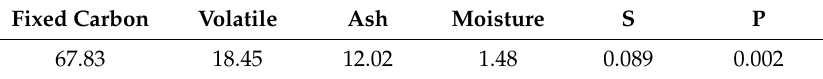
Table 3. Proximate analysis of of coal (wt %).